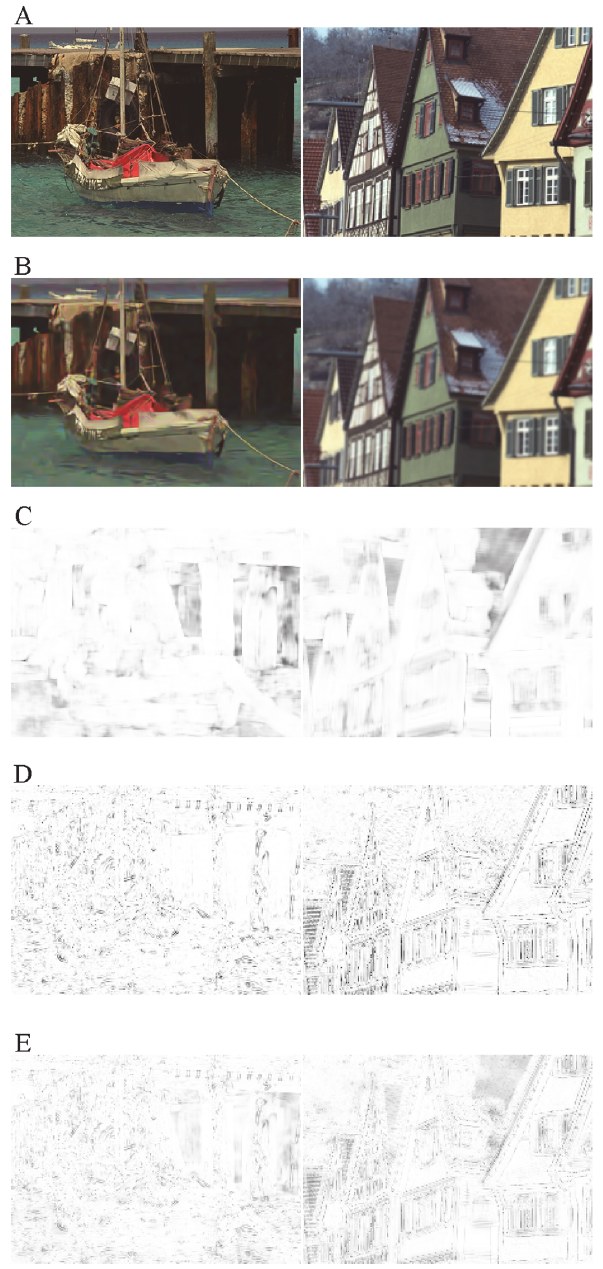
Fig 6. Examples of S inter , S intra , and S I maps. (A) Reference images. (B) Distorted images. (C) Map of inter- patch similarity index. (D) Map of intra-patch similarity index. (E) Map of integrated similarity index. For Fig. 6C-6E, the similarity indices are linearly mapped to [ 0 , 255 ] for visible exhibition.